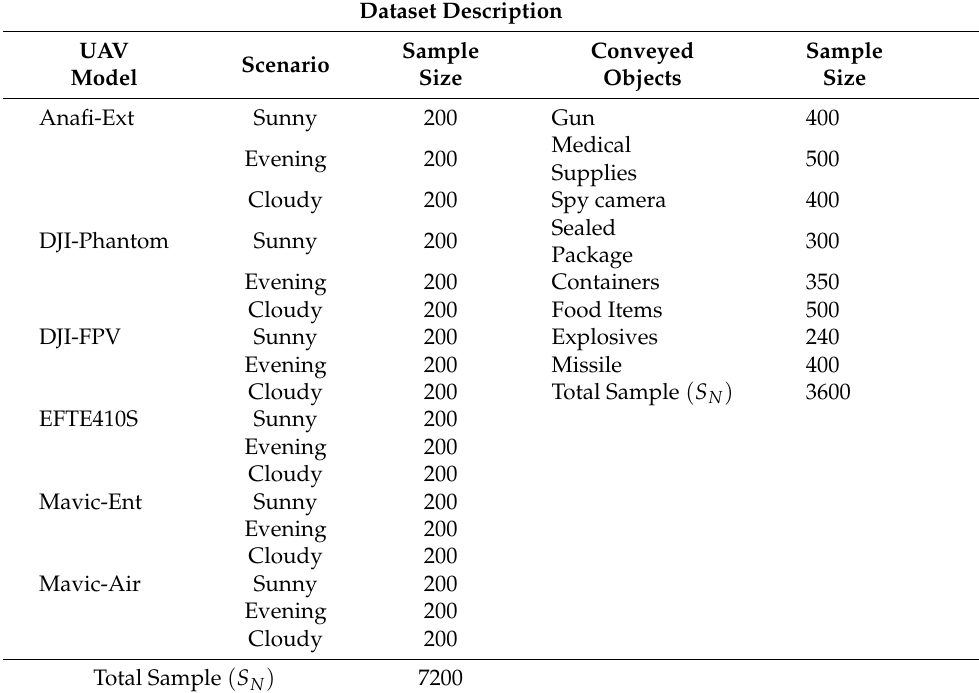
Table 2. Dataset Characterization.